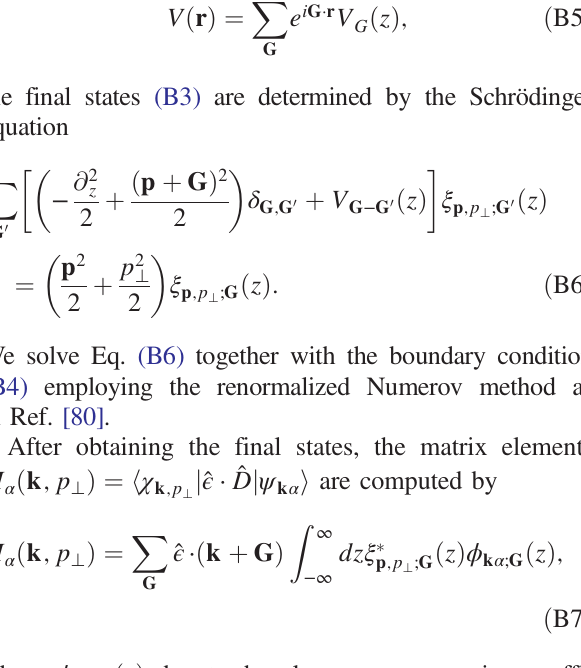
FIG. 8. Comparison of the ARPES intensity I ð k ; ε different binding energies within the ab initio method and the TB+one-step approach. We show the characteristic path in the BZ orthogonal to Γ - K passing through K (see